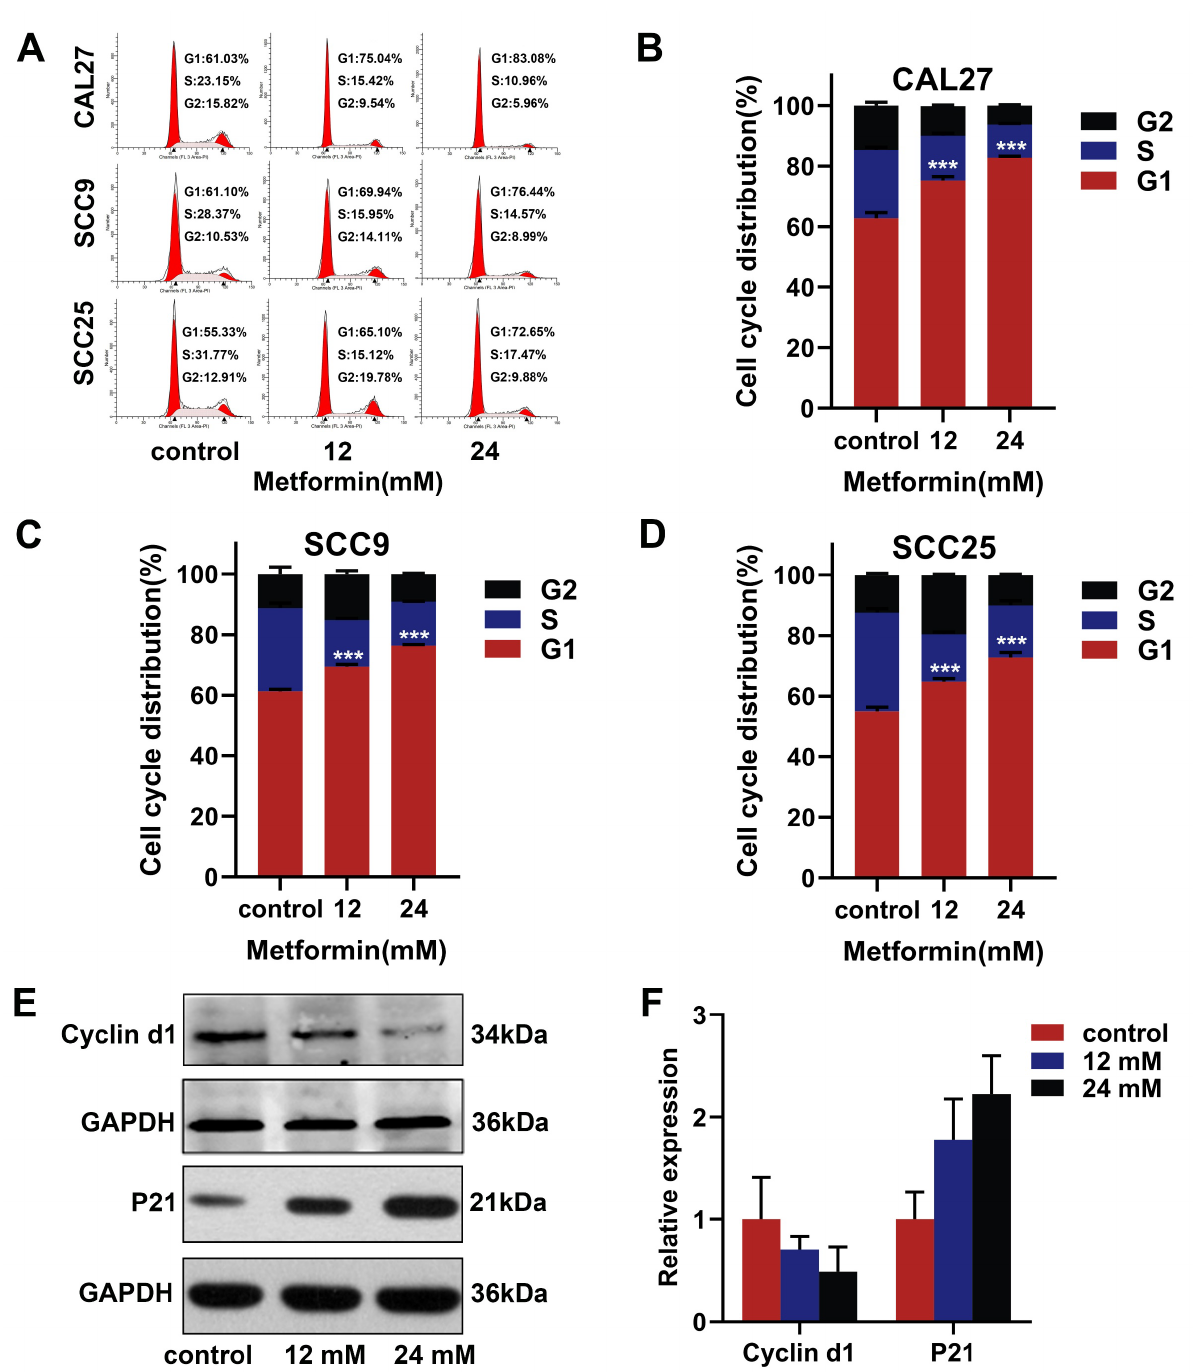
Figure 3. Metformin induced G1 phase cell cycle block in OSCC cells. ( A – D ) After treatment with various concentrations of metformin for 48 h, flow cytometry assays were performed to assess the impact of metformin on the cell cycle distribution of OSCC cell lines (CAL27, SCC9, SCC25). ( E , F ) CAL27 cells were treated with different concentrations of metformin for 48 h, and, then, the cell cycle related proteins were analyzed by western blot. Original blots see Supplementary Figure S4. GAPDH was used as the internal reference protein. The data are shown in the bar graph as mean ± SD, *** p ≤ 0.001 versus control